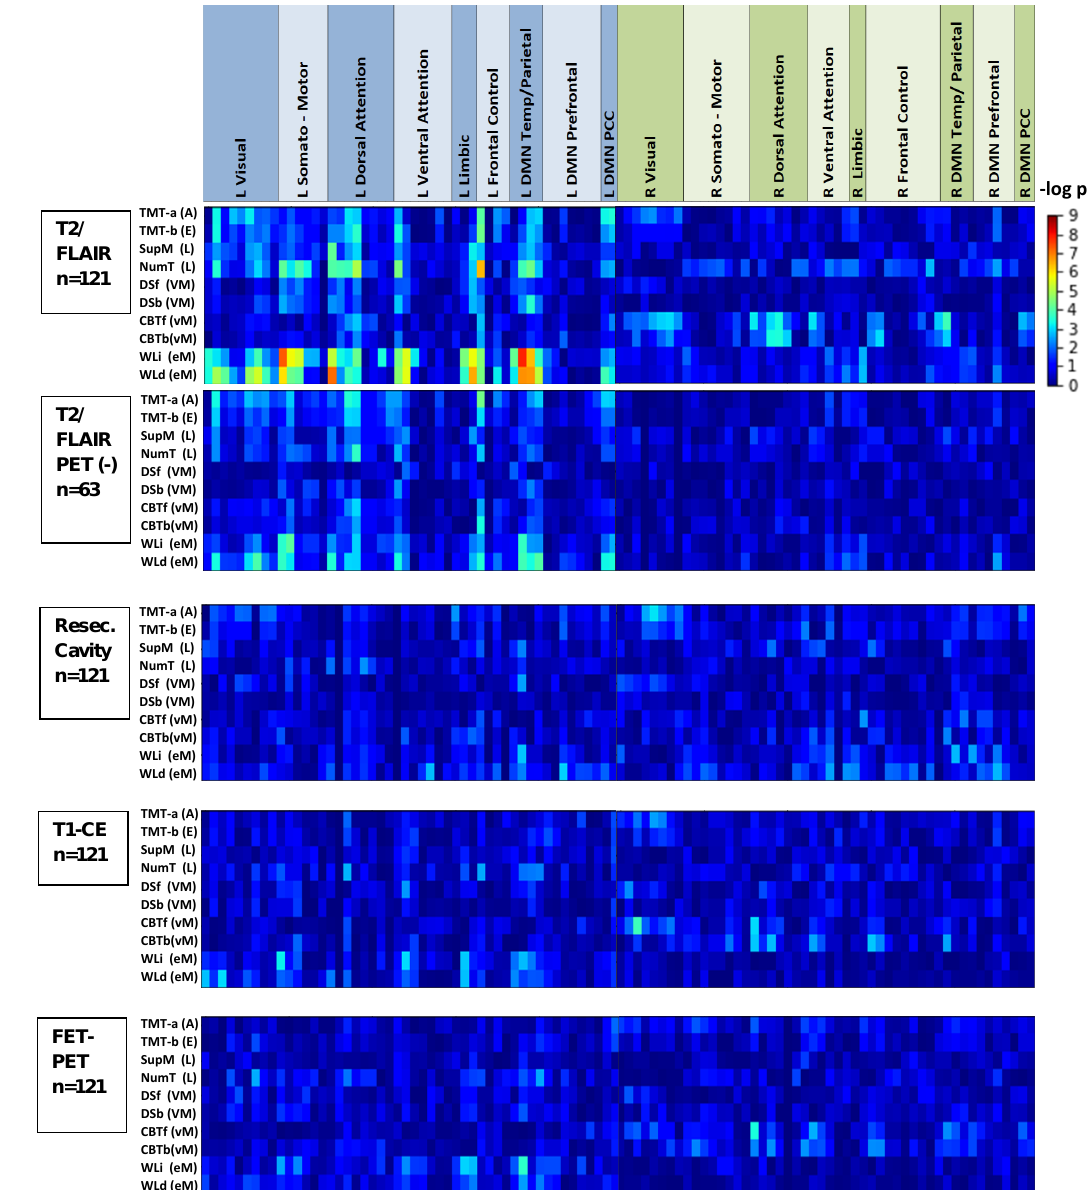
Figure 3. Heatmap of the correlation analysis between the volumetric overlap of four types of lesions with the functional cortical areas of an atlas-based parcellation [17] and the scores of 10 cognitive tests in n = 121 WHO Grade III/IV glioma patients. The functional nodes are ordered by location in the left or right hemisphere and the essential resting-state networks. p -values are given for the Kendall-tau-b rank correlations. T2/FLAIR: lesions semi-automatically segmented in T2-weighted and FLAIR MR images; T2/FLAIR PET (-): p -values for a group of n = 63 patients with an absence of FET-PET-positive tumor growth; Cavity: manually segmented resection cavity; T1-CE: semi-automatically segmented contrast-enhancing regions in T1-weighted MR images; FET-PET: semi-automatically segmented FET-PET-positive lesions; DMN: default mode network; PCC: posterior cingulate gyrus; TMT-a (A): trail-making—Test A (attention); TMT-b (E): trail-making—Test B (executive functions); SupM (L): supermarket test (language); NumT (L): number transcoding (language); DSf (VM): digit span forward (verbal working memory); DSb (VM): digit span backward (verbal working memory); CBTf (vM): Corsi block tapping forward (visual working memory); CBTb (vM): Corsi block tapping backwards (visual working memory); WLi (eM): word list immediate recall (verbal episodic memory); WLd (eM): word list delayed recall (verbal episodic memory). No significant correlations were observed for the TMT-b/TMT-a